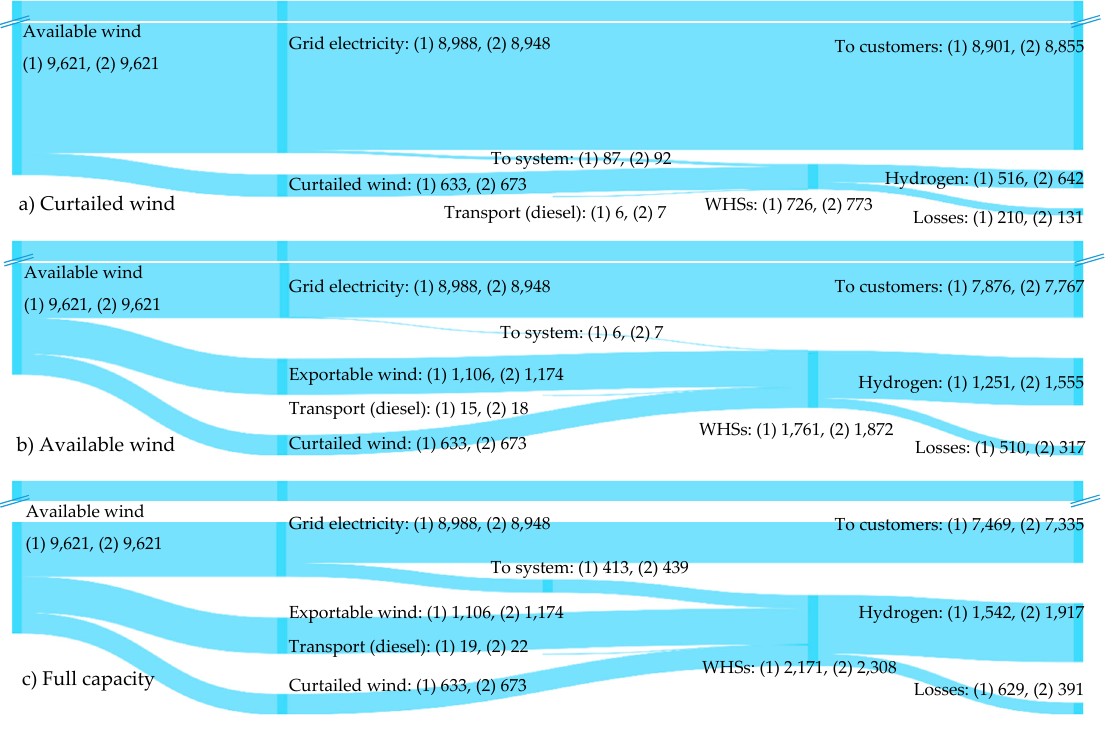
Figure 9. Energy flows (GWh) using (1) current and (2) future techno-economic parameters to all WHSs in Ireland of ( a ) curtailed wind operation, ( b ) available wind operation, and ( c ) full capacity operation.